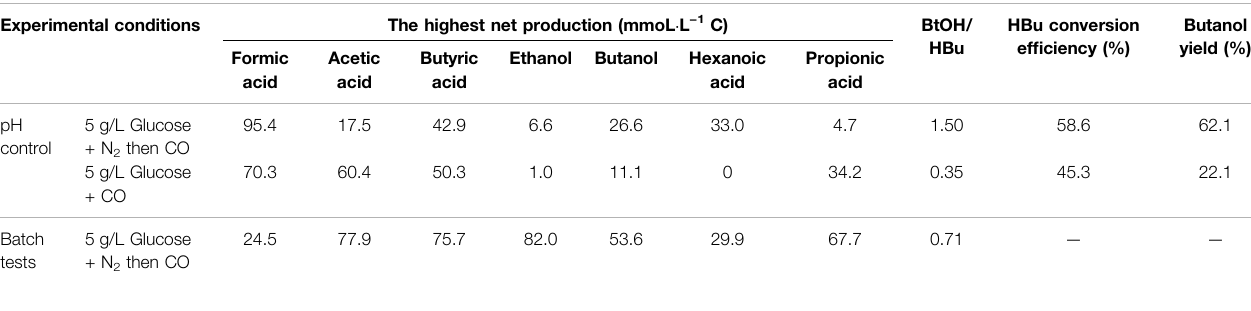
TABLE 2 | The highest net production of acids and alcohol, mole ratio of butanol to butyric acid and butanol yield. Experimental